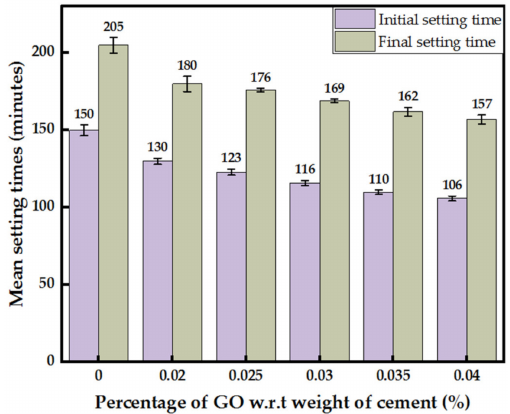
Figure 5. Initial and final setting times of cement paste incorporated with GO